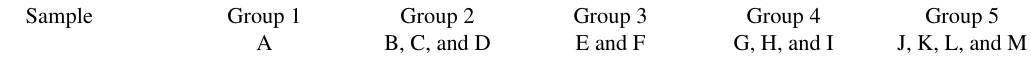
Table 2. Parameters of the soot-containing particles of TEM samples. Sample Group 1